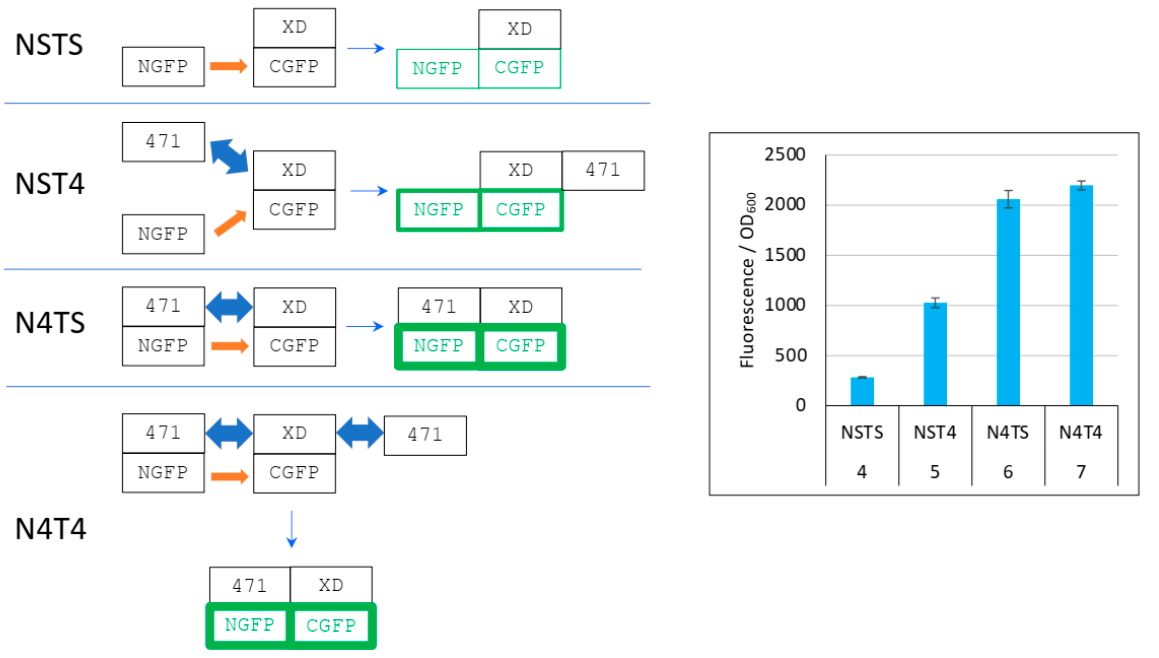
Figure 6. Explanation of Figure 4 results. Left panel, cartoon explaining the different protein interactions and the corresponding fluorescence results. XD-CGFP and NGFP-471 fusion proteins are represented as linked rectangles. Non-fluorescent proteins are shown in black. Fluorescent proteins are in green. The green border thickness is proportional to the intensity of fluorescence. The thin blue arrow points towards the final complex. Thick blue double arrow: fast, reversible interaction. Orange arrow: slow, irreversible interaction. To avoid any ambiguity, free 471 bound to XD is represented on the right of XD, whereas NGFP-471 bound to XD-CGFP is represented on the left of XD-CGFP. See main text for a description of NSTS, NST4, N4TS and N4T4. Right panel, Fluorescence data of a triplicate experiment run overnight. Numbers 4 to 7 of the x -axis refer to the experimental conditions described in Figure